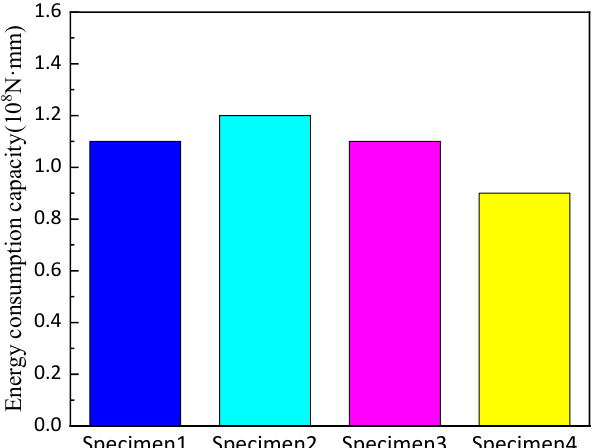
Figure 14. Comparison of energy consumption capacity of the specimens.